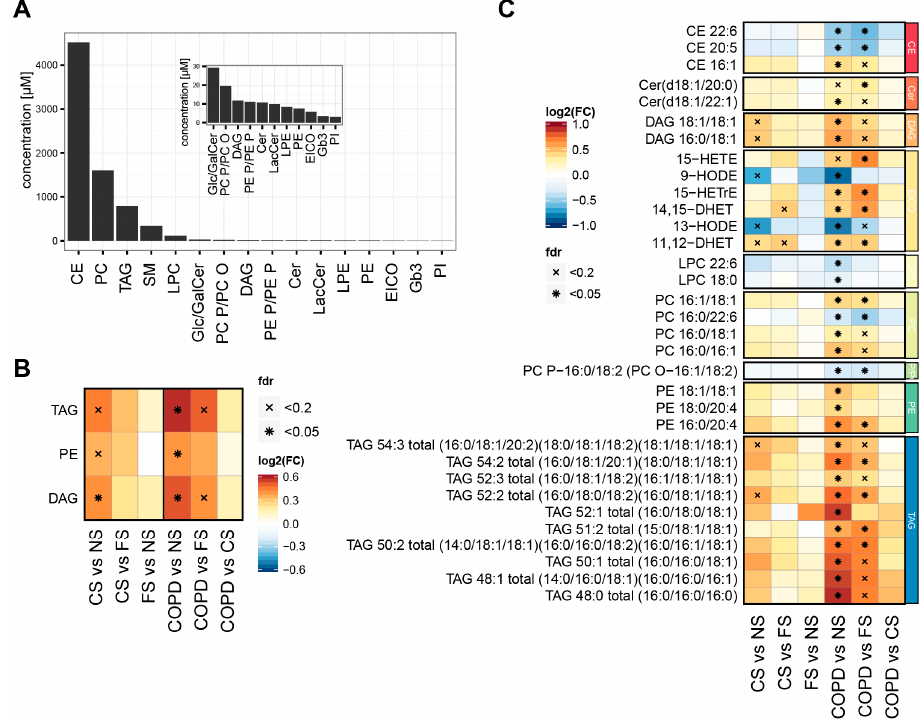
Figure 1. The serum lipidome reflects smoking and chronic obstructive pulmonary disease (COPD) status. ( A ) Measured lipid classes and their median concentrations; ( B ) differentially abundant lipid classes. The heatmap shows lipid classes ( y -axis) with significant difference in abundance in any of the group comparisons ( x -axis). The log 2-fold change is color-coded (see color key). Statistical significance is marked: ×, FDR adjusted p -value < 0.20, *, FDR adjusted p -value <0.05. Sex, age group, and body mass index were used as covariates in the statistical model; ( C ) differentially abundant lipid species. Heatmap as in Figure 1 B , but for individual lipids. The lipids are grouped by class (color bar on right). See the abbreviations section for lipid nomenclature. Triacylglycerols (TAGs)